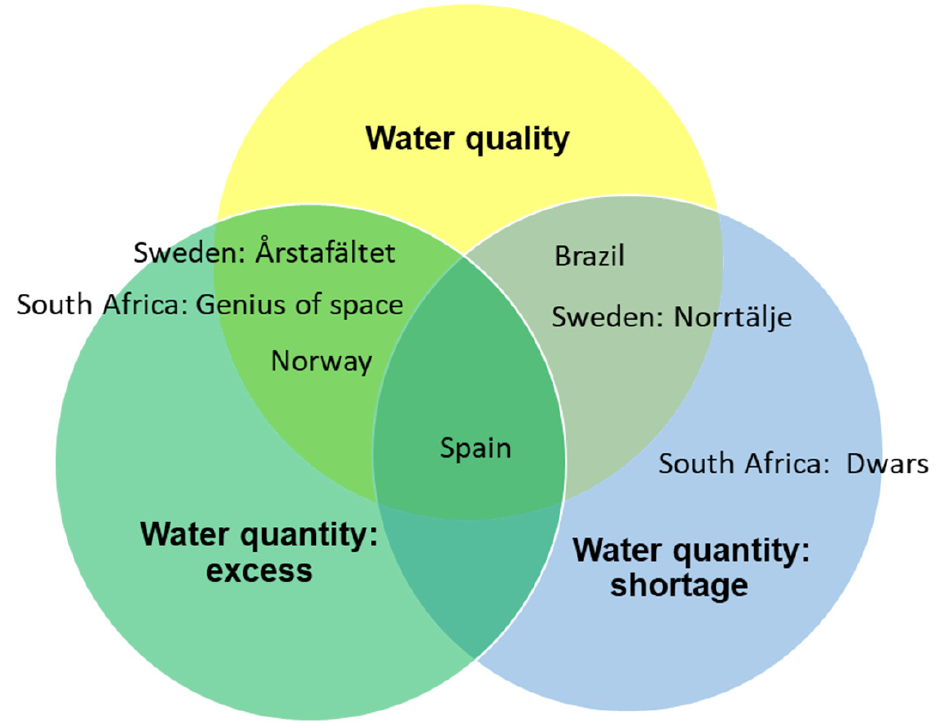
Figure 2. The case studies grouped according to whether the NBS addresses water quality, water excess or water shortage problems.